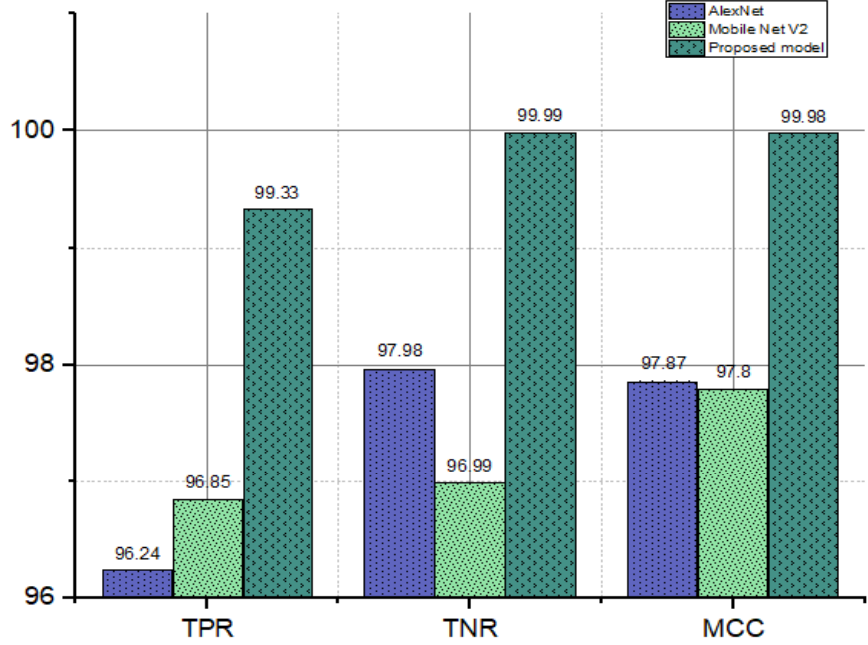
Figure 9. Bar chart of the attained values of the TPR, TNR, and MCC of the proposed model and the other TL models.